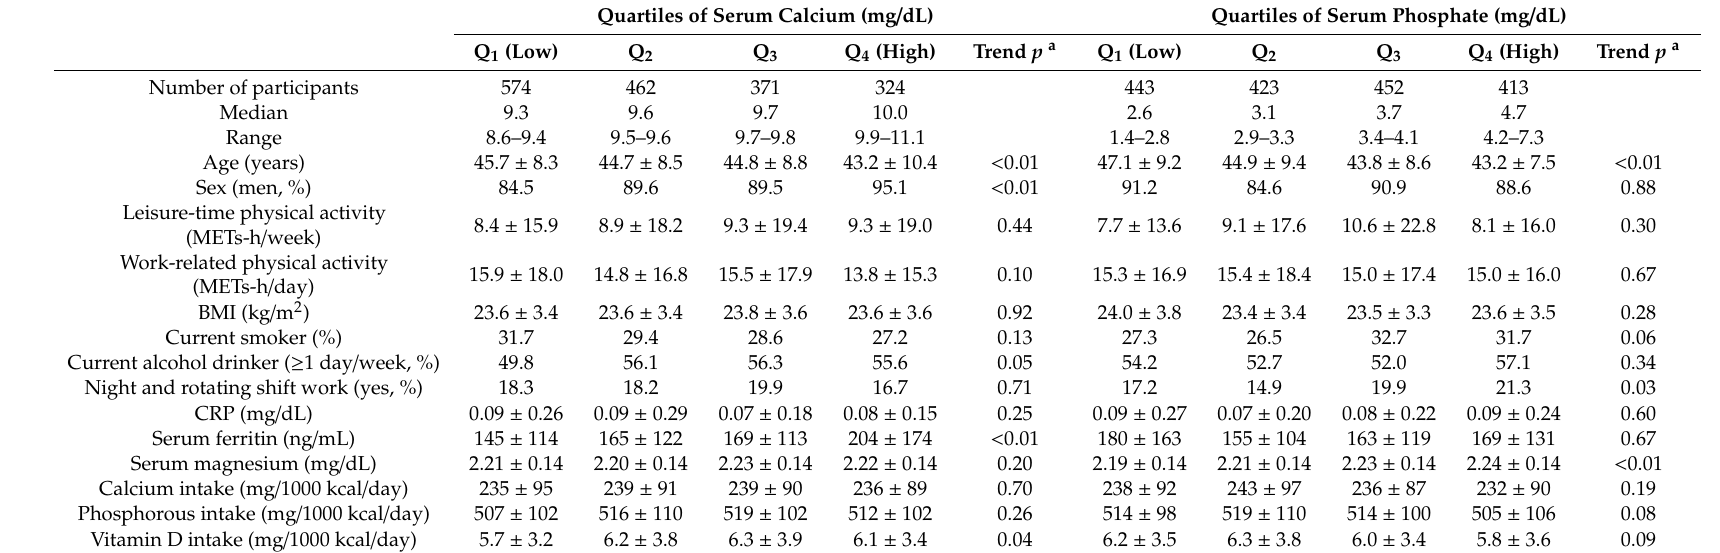
Table 1. Characteristics of the study participants by quartiles of serum calcium and